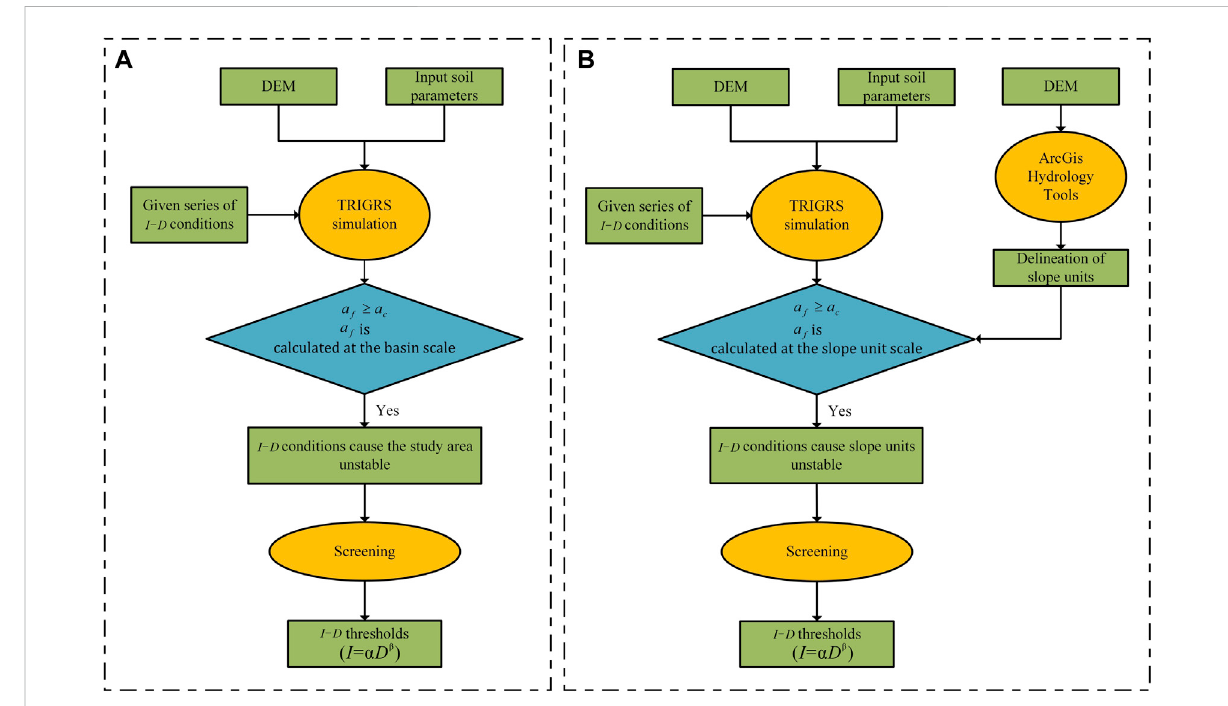
FIGURE 3 The fl owchart of the de fi nition of I-D thresholds based on TRIGRS (A) at the basin scale and (B) at the slope unit